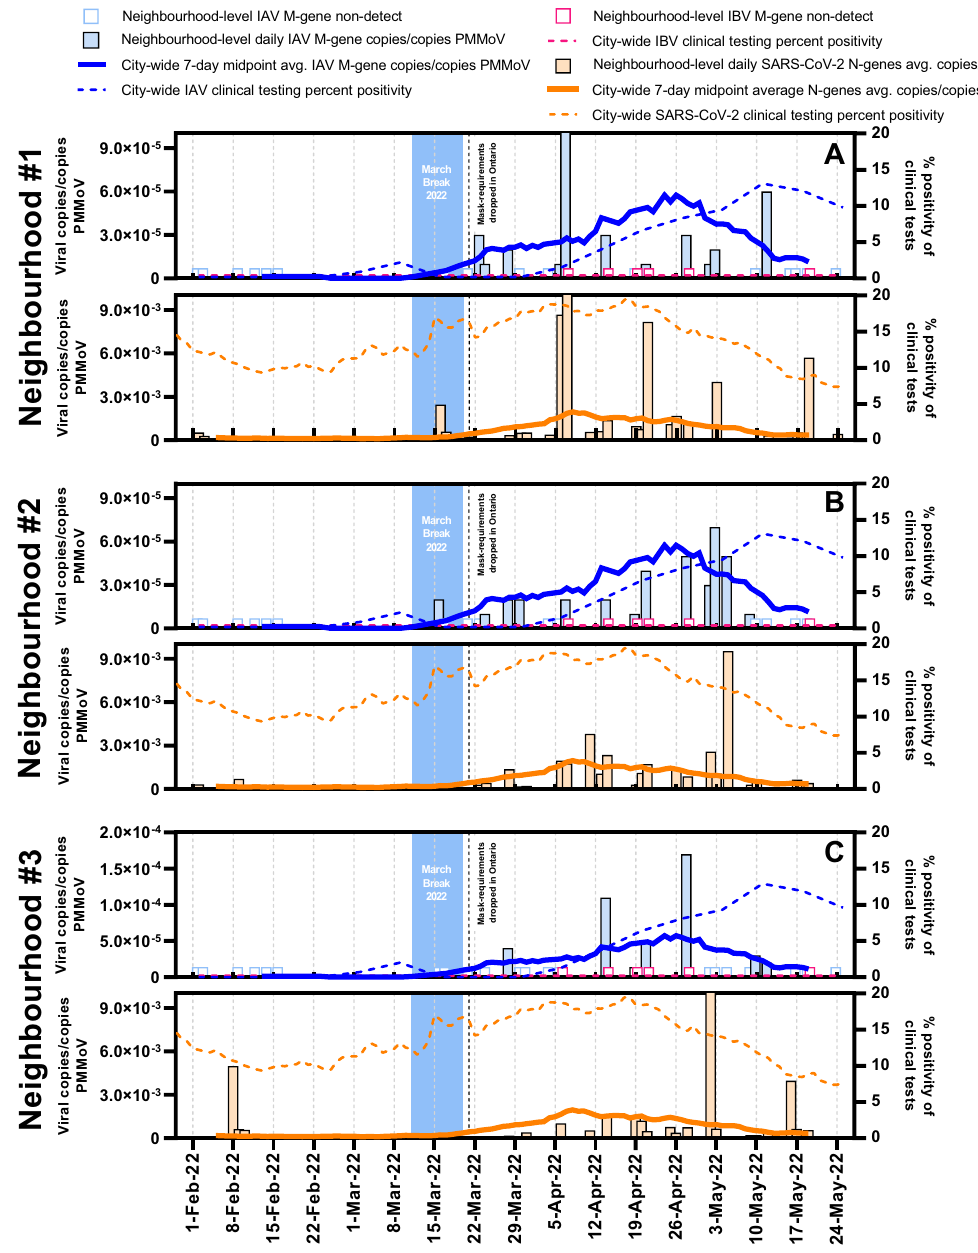
Figure 3. Comparison of both IAV and SARS-CoV-2 wastewater signals at the neighbourhood level ( A – neighbourhood #1, B –neighbourhood #2 and C –neighbourhood #3) in Ottawa, for samples harvested from the sewer system. The normalized IAV viral signal differed between neighbourhoods and with the citywide signal when population characteristics